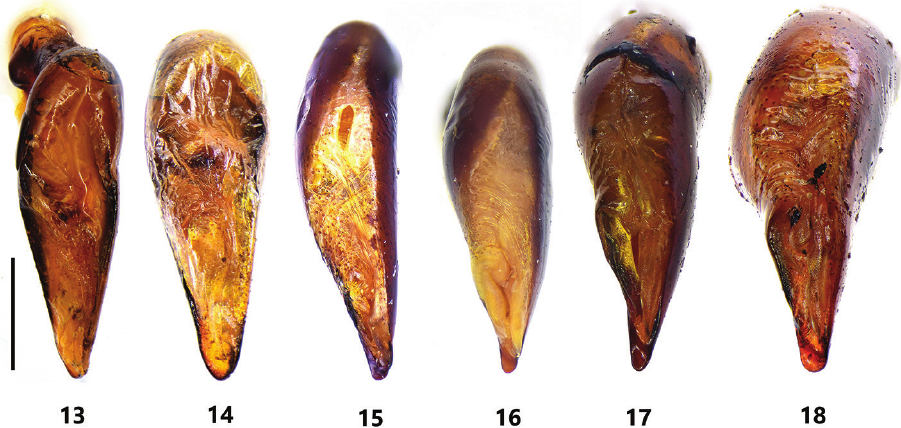
Figures 13–18. Male genitalia of Pterostichus ( Koreonialoe ) spp. from China, dorsal view of median lobe of aedeagus 13 P. micropoides sp. nov., Holotype 14 P. micropoides sp. nov. Paratype from Changbai county 15 P. syleus Kirschenhofer, a male from Fengcheng city, Liaoning 16 P. syleus Kirschenhofer, a male from Shedao Island, Liaoning 17 P. quadrilobatus sp. nov., Paratype from Laopingding, Liaoning 18 P. bellatrix Tschitschérine, a male from Changbai county, Jilin. Scale bar: 1 mm.